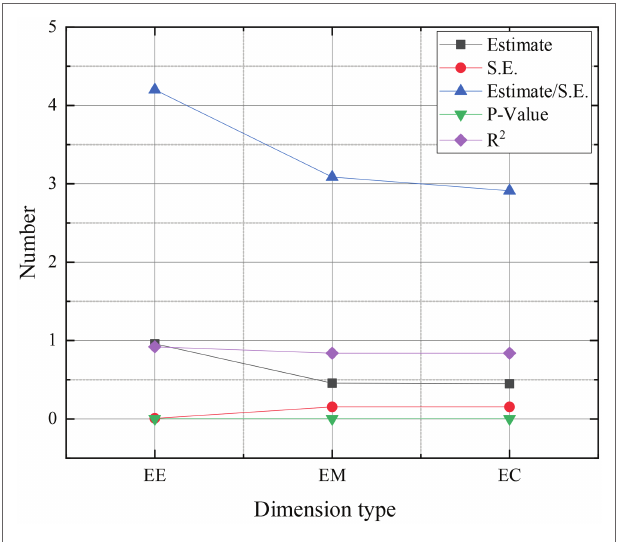
FIGURE 8 | Results of the hypothesis analysis of the model (S.E.: regression standard deviation; R 2 : determination coefficient).